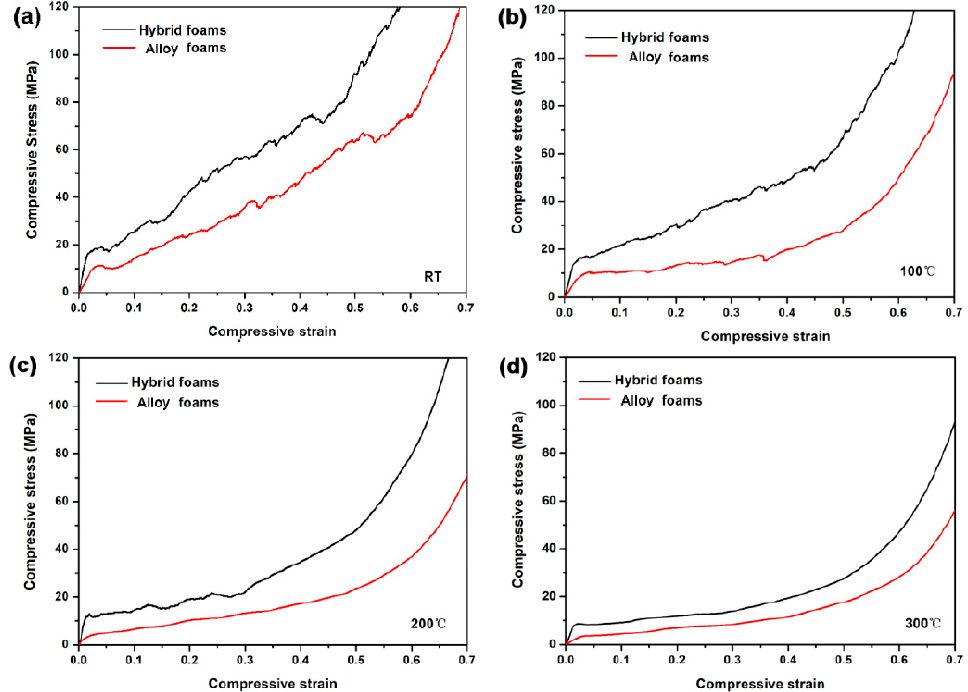
Figure 7. The compressive stress–strain curves of alloy foams and hybrid foams at elevated tem- peratures: ( a ) RT; ( b ) 100 °C; ( c ) 200 °C; ( d ) 300 °C. tures: ( a ) RT; ( b ) 100 ◦ C; ( c ) 200 ◦ C; ( d ) 300 ◦